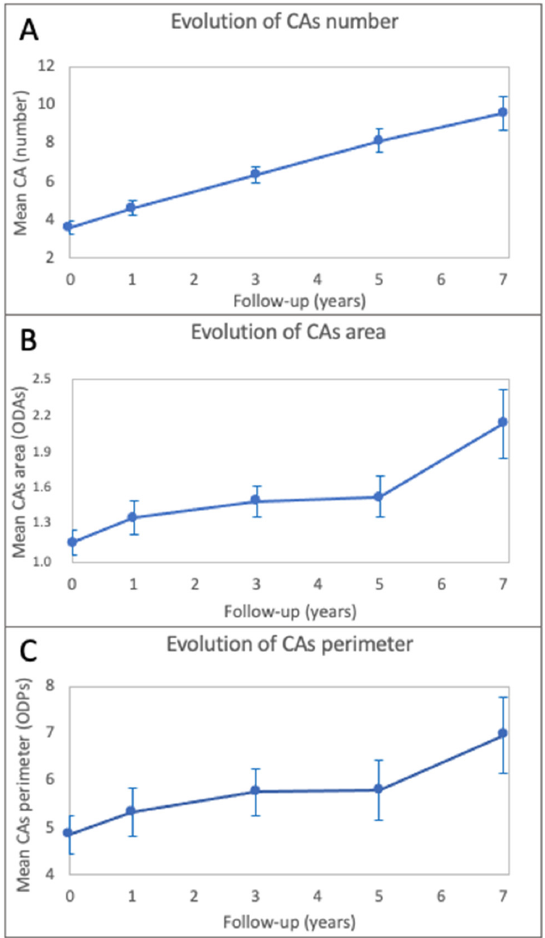
Figure 3. Graphical representation of the evolution along time of the CAs number ( A ), CAs area ( B ) and CAs perimeter ( C ); mean point and error bars are presented in the graphs. The statistical significance was maintained even when considering separately inter- vals between different follow-up visits ( p = 0.0418 for T5 vs. T7, p < 0.0001 for all the other time intervals): data are shown in Table 3. Table 3. p -values and coefficients of the multiple linear regression analysis conducted on the variation of the CAs number, area and perimeter over time, considering intervals between different follow-up visits; statistically significative values are in bold; the patient’s age at baseline and baseline value of the measures were the covariates included in the models.